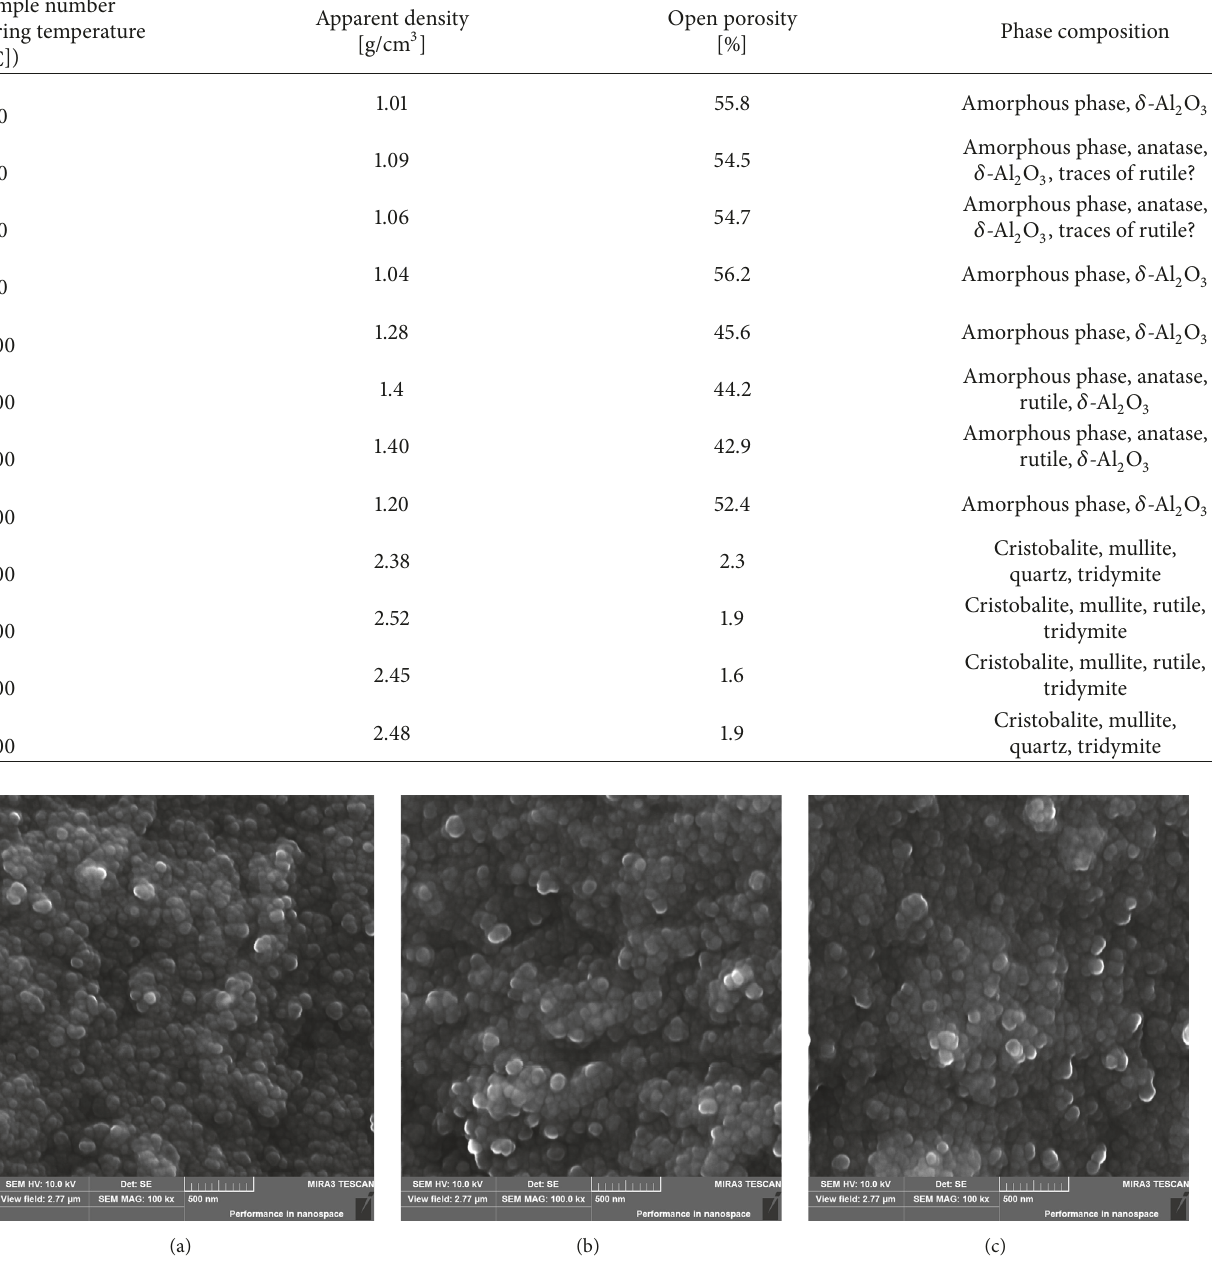
Table 5: Results of selected physical properties for samples with compositions given in Table 4.